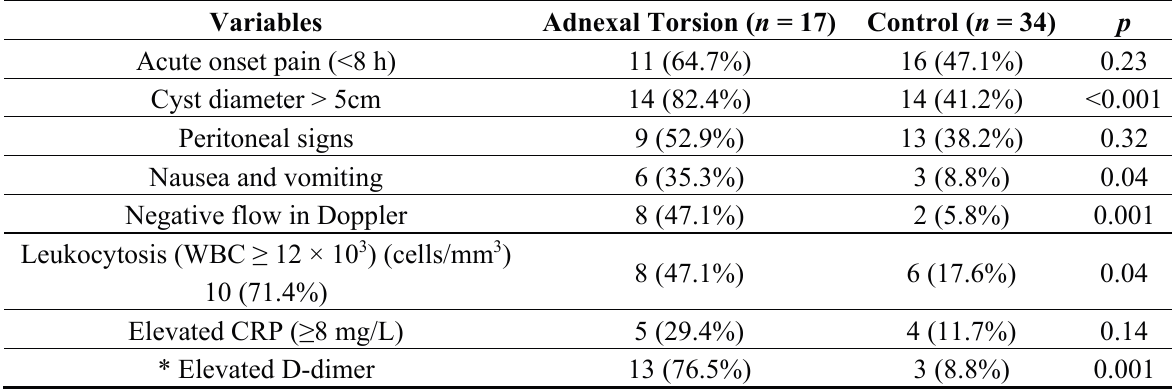
Table 4. Comparison of clinical and laboratory features among groups.